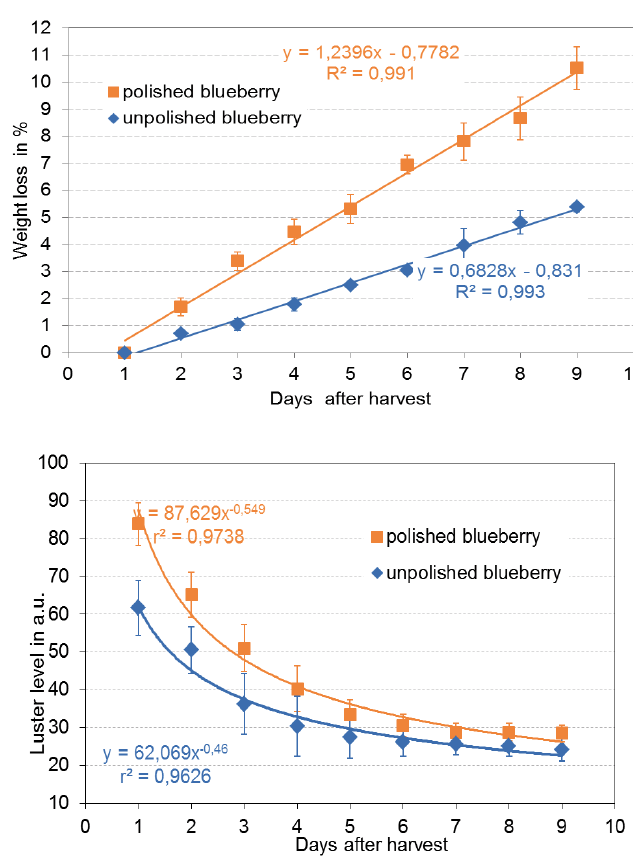
Fig. 4: Weight loss (a, top; mean of 25 berries) and luster levels (b, bottom) of polished (orange) or unpolished (blue) blueberries plotted over time during nine days of storage at 6 °C and 55% rh (n = 25) and SD (standard deviation); colour coding is identical in Fig. 3 and 4.